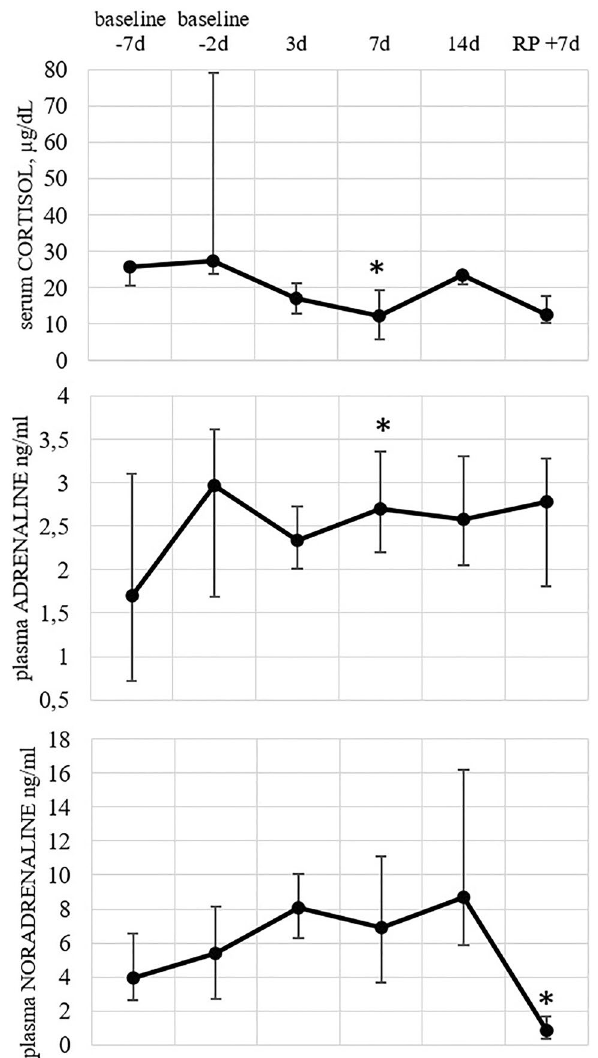
Figure 6. Blood hormone concentrations at the indicated timepoints. Markers represent medians, whiskers represent quartiles q75 and q25; asterisk (*) indicates p -value ≤ 0.05 in Wilcoxon